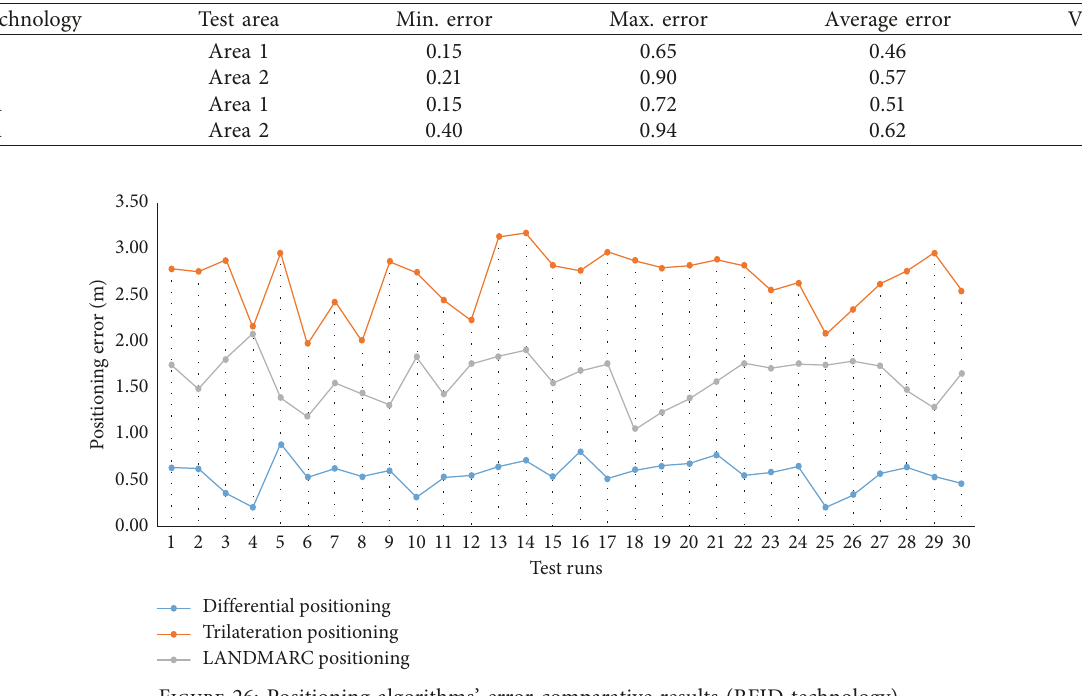
Figure 25: Positioning algorithm’s RMSE results. (a) Positioning error results in test area 1 (little environmental interference). (b) Positioning error results in test area 2 (substantial environmental interference). Table 2: Experimental results: RMSE summary statistics.